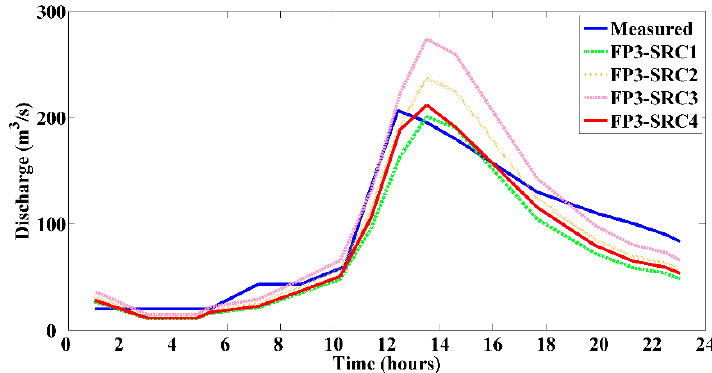
Figure 7. Comparison of the measured and simulated FP3 under the four SRCs.